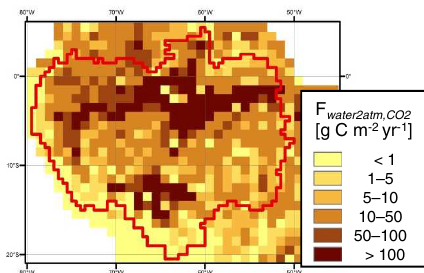
Figure 16. Simulated average CO 2 evasion from rivers, floodplains and headwaters (summed up as F water2atm ) for the period 1980– 2000. The evasion flux is reported relative to the total area of each grid